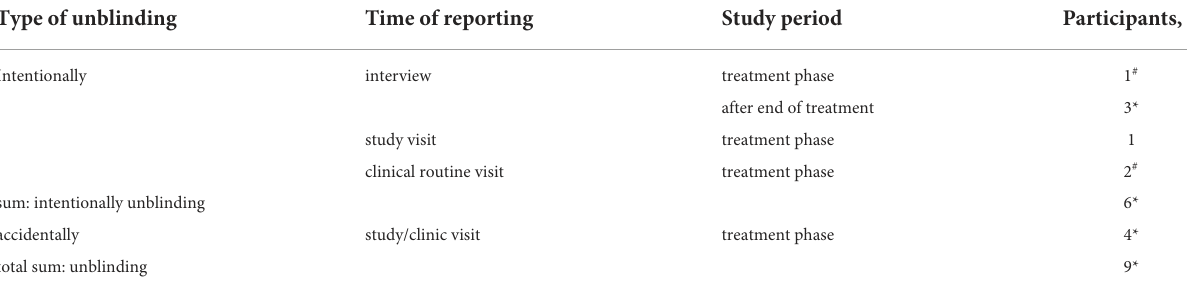
TABLE 1 Participants reported unblinding depending on the type of unblinding and study period. Type of unblinding Time of